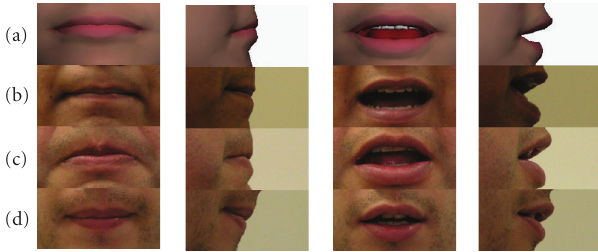
Figure 2: The left two columns show the front and side views of the viseme M. The right two columns show the front and side views of the viseme A. (a) The synthetic face; (b) Person A; (c) Person B; (d) Person